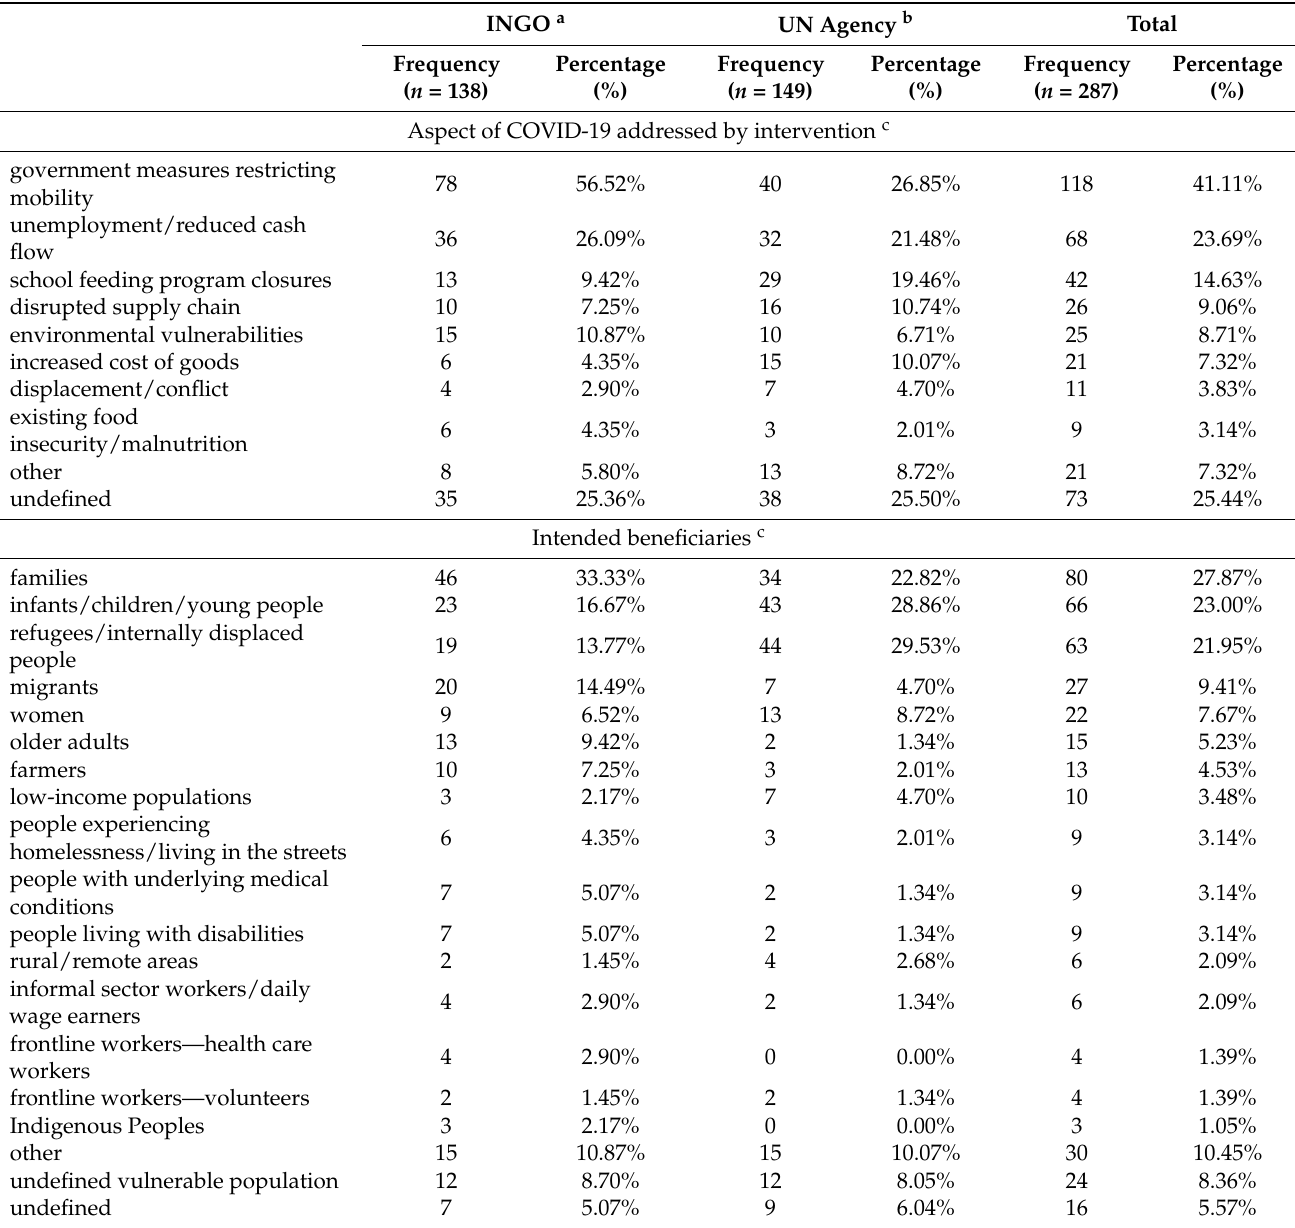
Table 5. Intended beneficiaries of food security interventions delivered by INGOs and UN agencies in response to